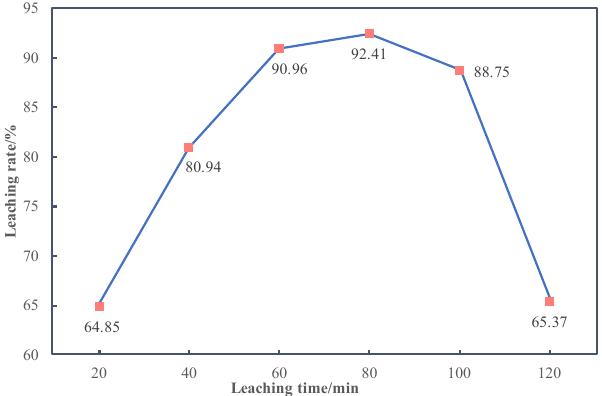
Figure 5. Effect of time on leaching rate of titanium.